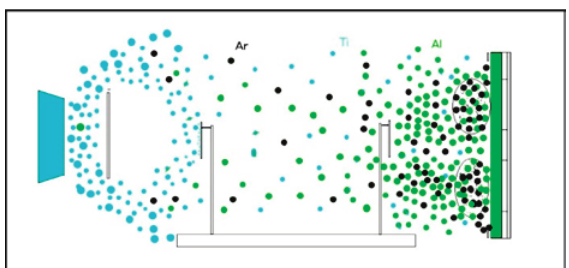
fig. 7. Schematic diagram of intermetallic